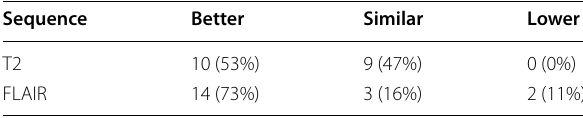
Table 4 Classify the lesions of tuberous sclerosis according to visibility in DIR compared to T2 and FLAIR Sequence